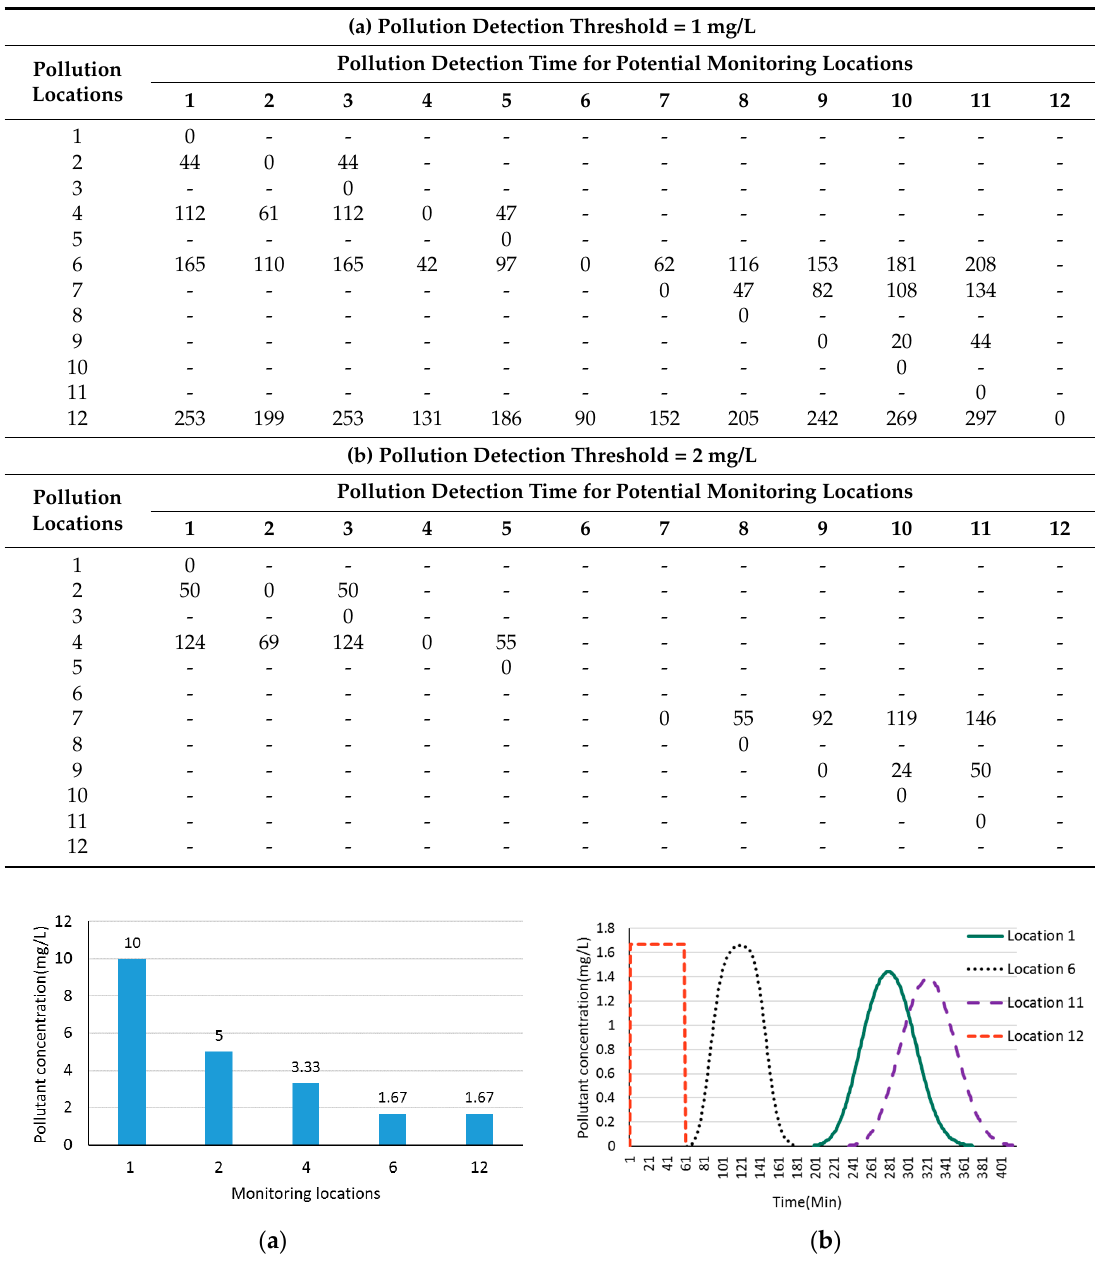
Table 9. Pollution detection time for river network B with higher pollution detection thresholds. (a) Pollution Detection Threshold = 1 mg/L